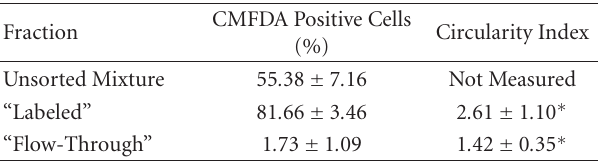
Table 2: E ffi cacy of